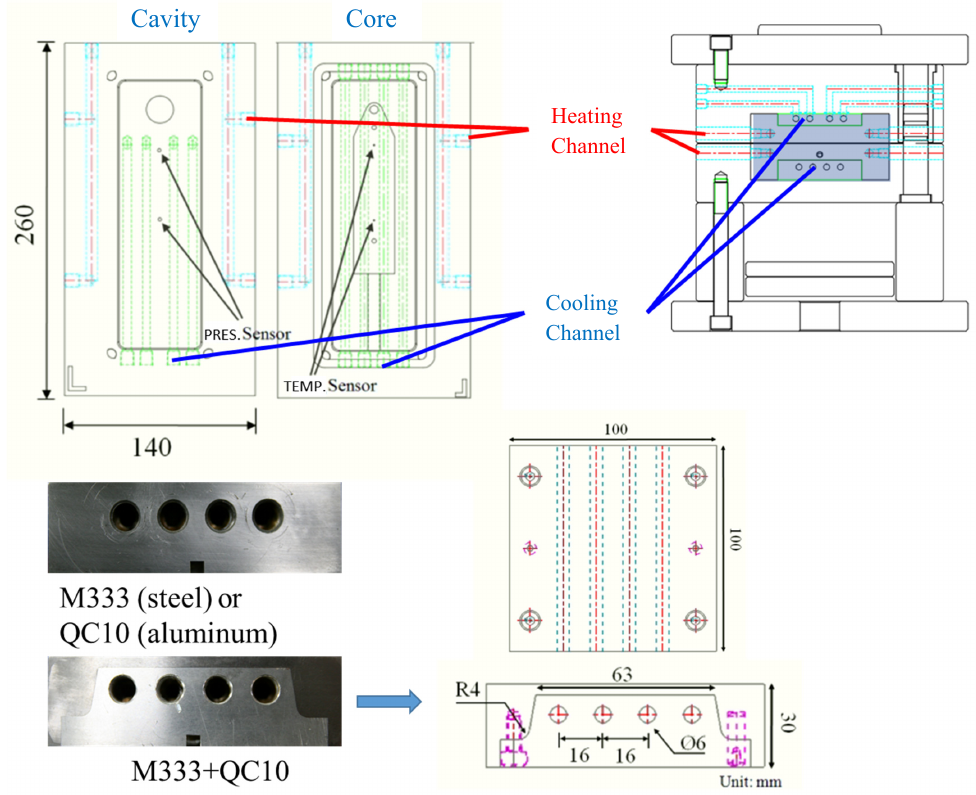
Figure 4. A mold schematic with three mold cooling blocks as well as part geometry [26].